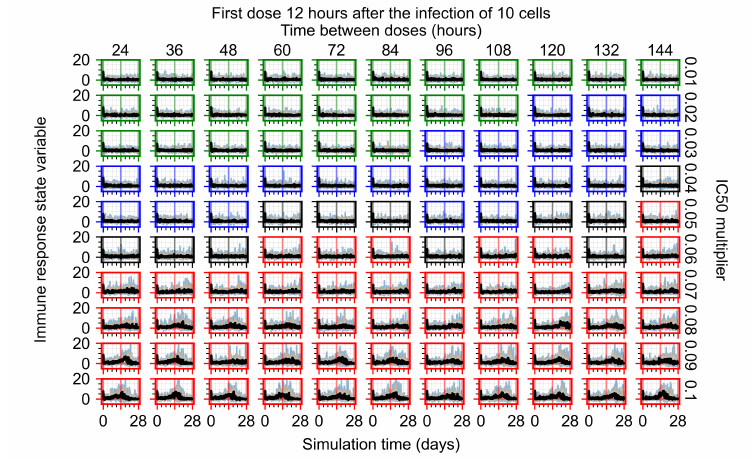
Figure A20. Immune response state variable number. Positive values correspond to an inflammatory state, and negative to an anti-inflammatory state.